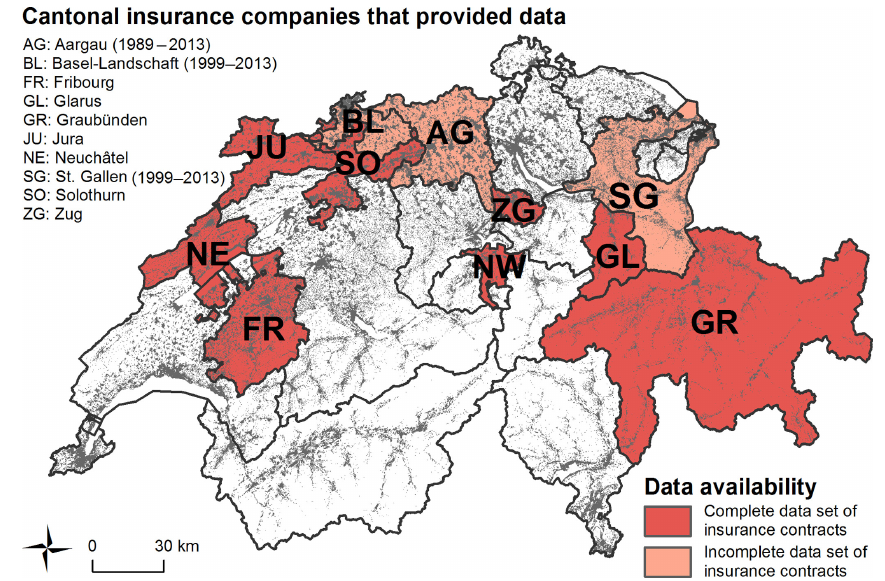
Figure 2. Overview of provided data by the cantonal insurance companies for buildings. Three insurance companies only provided data limited to contracts associated with at least one flood claim within the period indicated in brackets. The grey-shaded areas indicate the footprints of all buildings in Switzerland. Map source: Federal Office of Topography (swisstopo). Table 2. Parameter values of the model M3, value per surface area (CHFm − 2 ) of seven types of land use, i.e. six types of building zones and the area outside of building zones, based on a complete portfolio data of eight cantonal insurance companies for buildings in Switzerland. Insured values of buildings, which are localized at least on street level, are directly assigned to a type of land use. Values of the remaining buildings are split over all types of land use according to the size of the area of each type. The results per type of land use, which are used for further analyses, are in bold. Table entries are ordered by rank of these